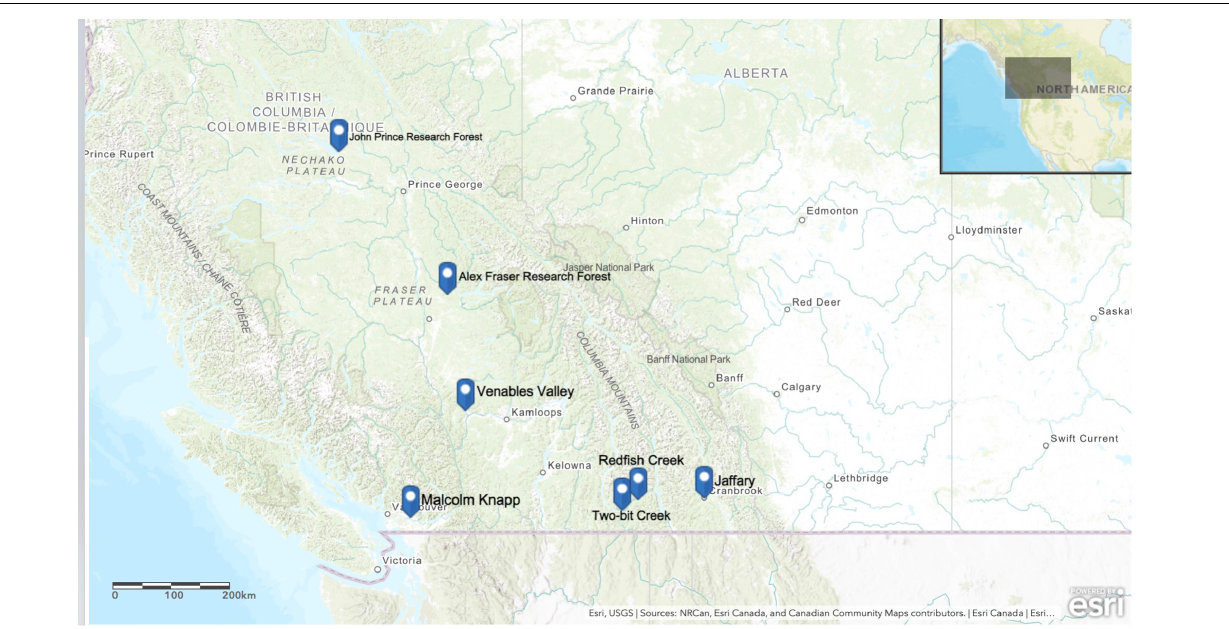
intact stems, no signs of insect/pathogen disturbance,